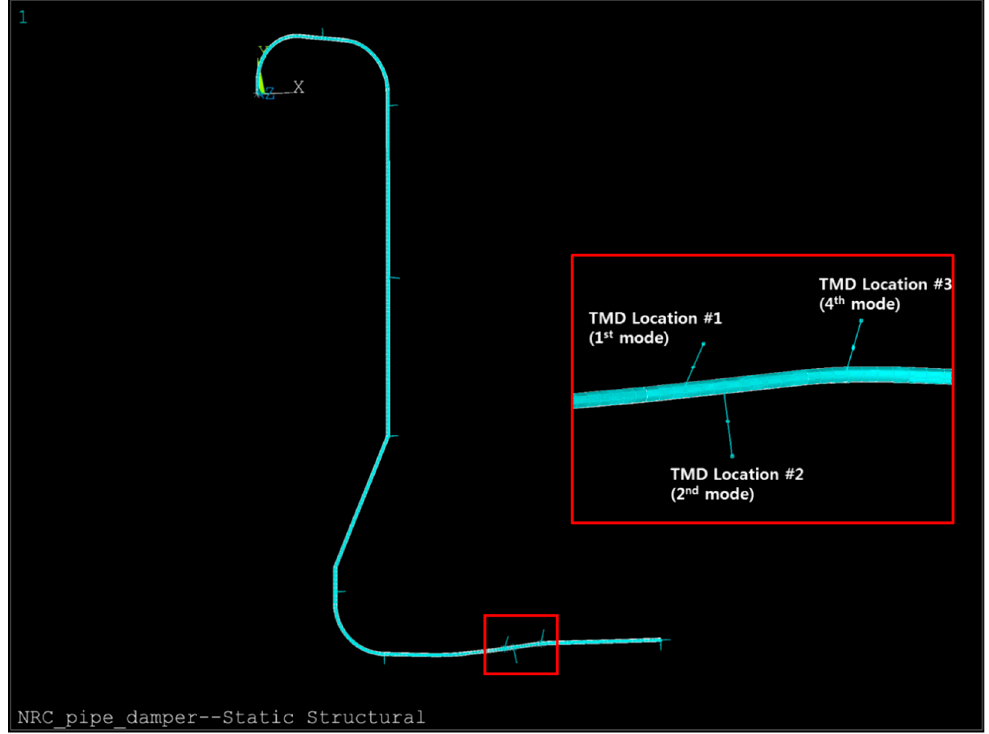
Figure 5. TMD-Piping coupled numerical model and locations of the TMD installation on the piping. Table 3. TMD optimal design values for the NUREG/CR-1677 Benchmark piping system: f opt & ζ d,opt.